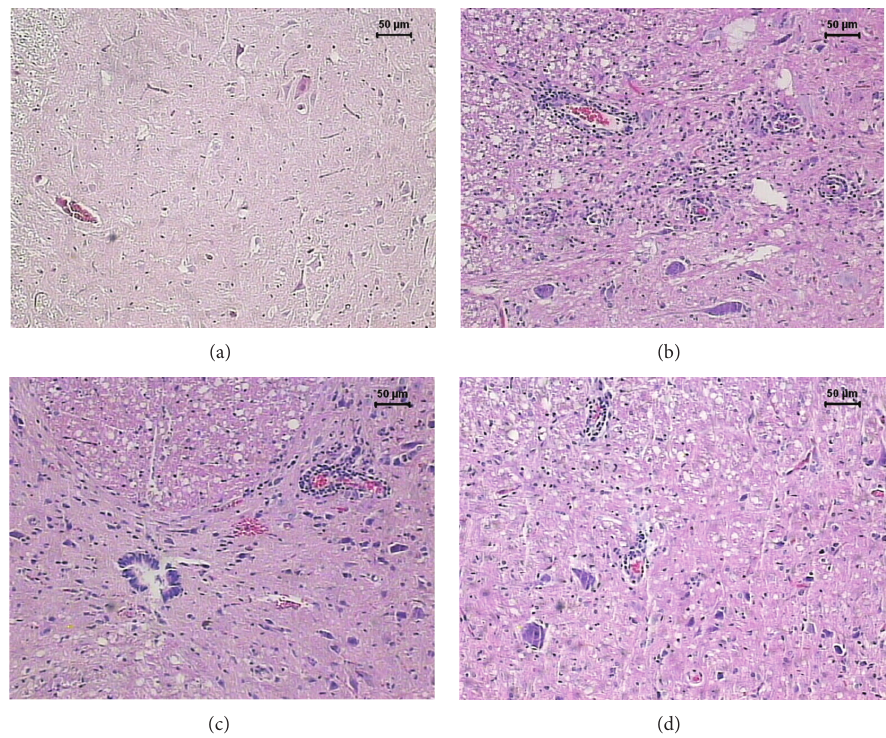
Figure 3: Effect of tuberculosis vaccines in spinal cord inflammation associated with EAE. Female Lewis rats were immunized with BCG alone or with BCG followed by pVAXhsp65 boosters and then underwent EAE induction by inoculation of MBP emulsified with CFA. Animals were euthanized during the recovery phase (20th day after MBP injection) and the lumbar spinal cord was removed and further stained by haematoxylin and eosin. Normal control (a), EAE control (b), rats immunized with BCG before EAE (c), and rats immunized with BCG/pVAXhsp65 before EAE induction